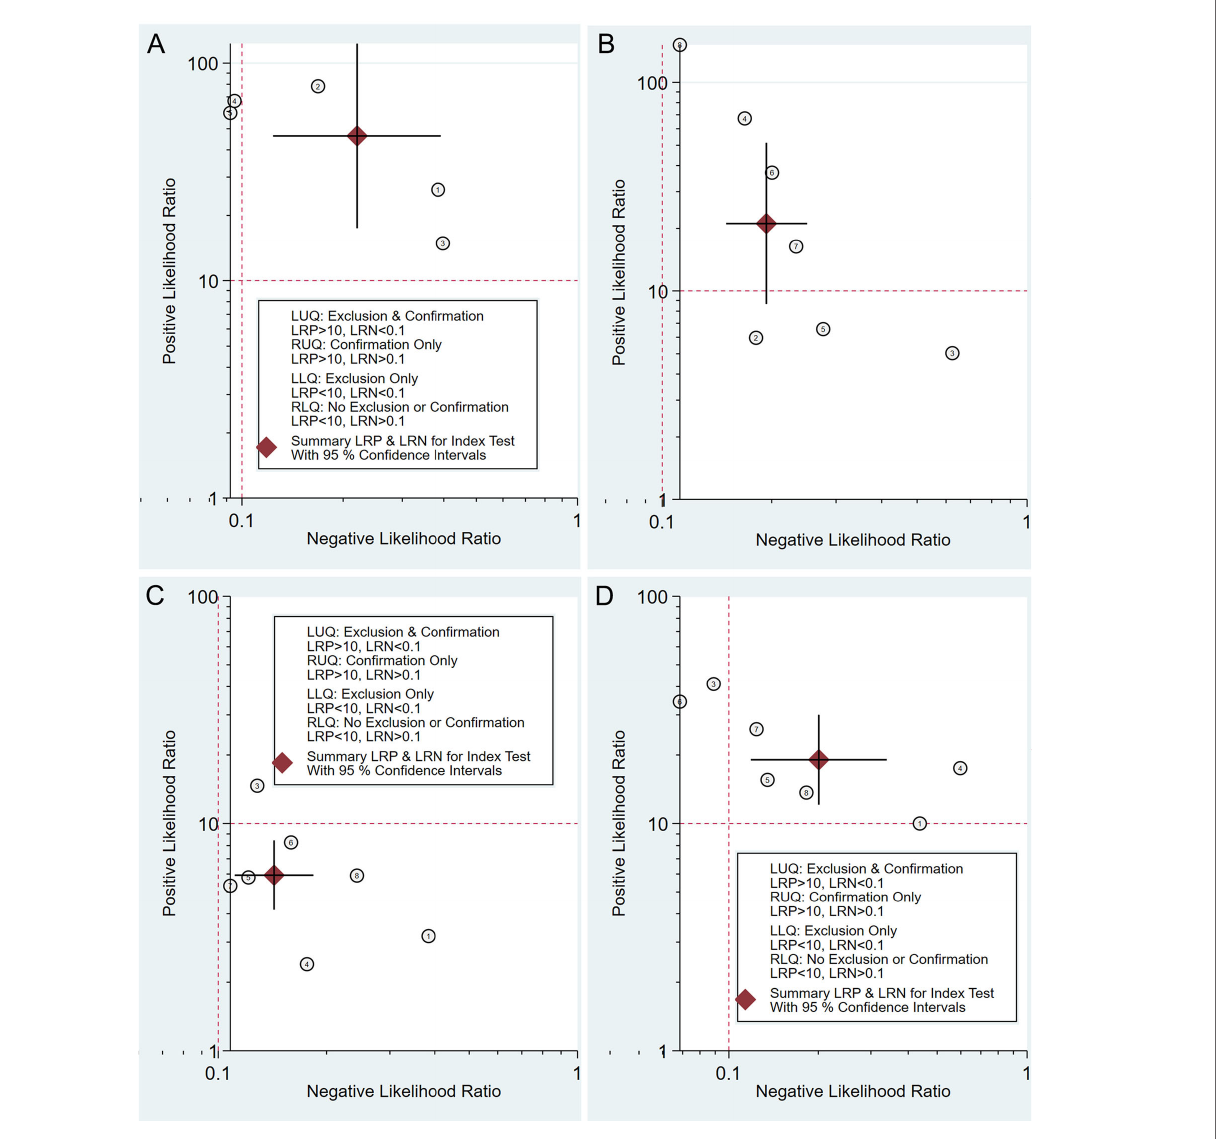
FIGURE 5 | Double contrast-enhanced ultrasonography performance to diagnose T1 (A) , T2 (B) , T3 (C) , and T4 (D) gastric cancer. Likelihood ratio (LR) scattergram de fi ning the quadrants of informativeness based on desirable thresholds (positive LR > 10, negative LR < 0.1): left upper quadrant (test suitable both for diagnosis exclusion and con fi rmation), right upper quadrant (con fi rmation only), left lower quadrant (exclusion only), and right lower quadrant (neither con fi rmation nor